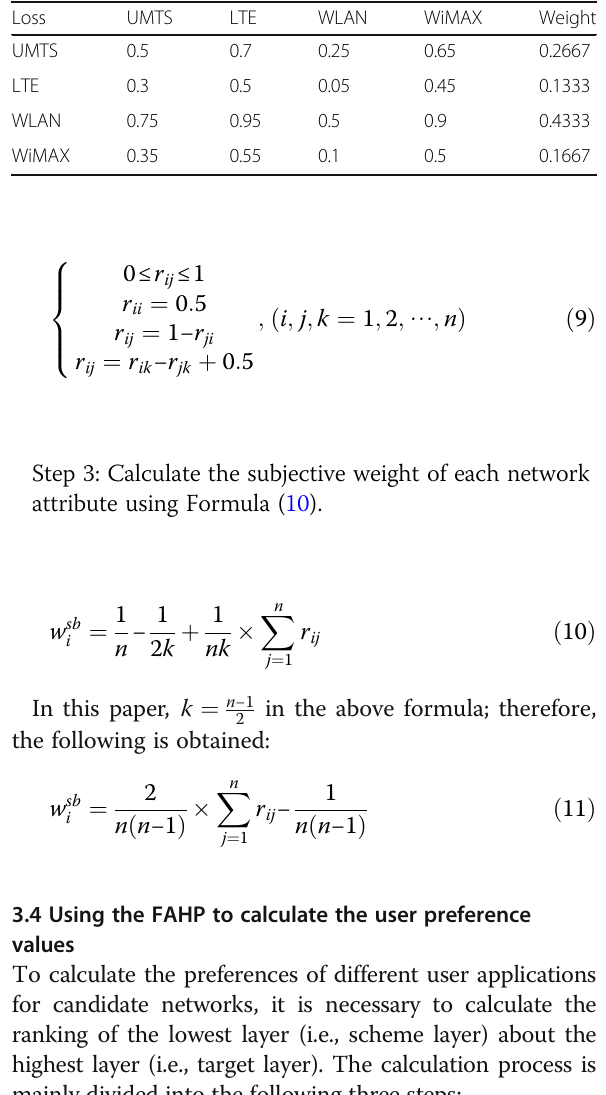
Table 12 Fuzzy consistent matrix and weights for delay